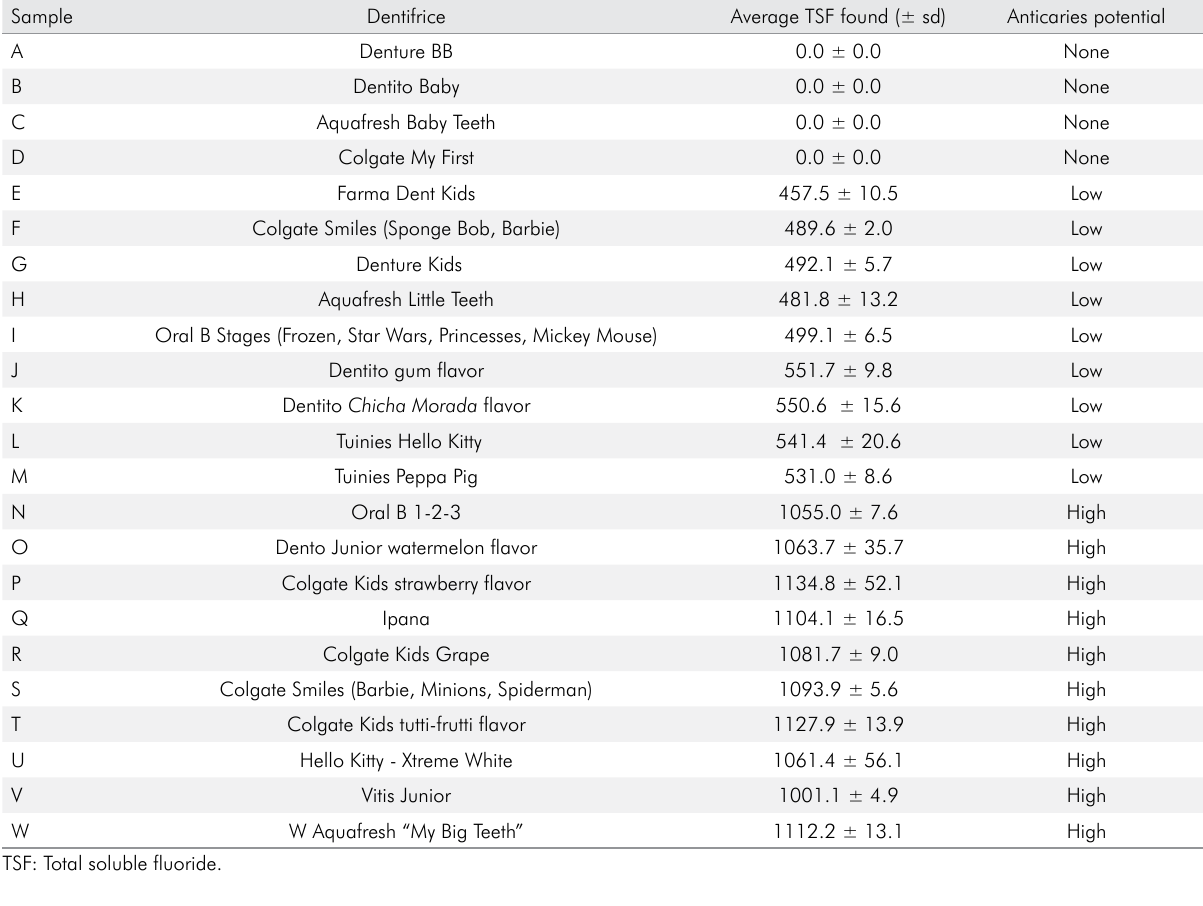
Table 3. Concentration of total soluble fluoride (average ±sd; n=3) in the dentifrices analyzed, and their anticaries potentials. Sample